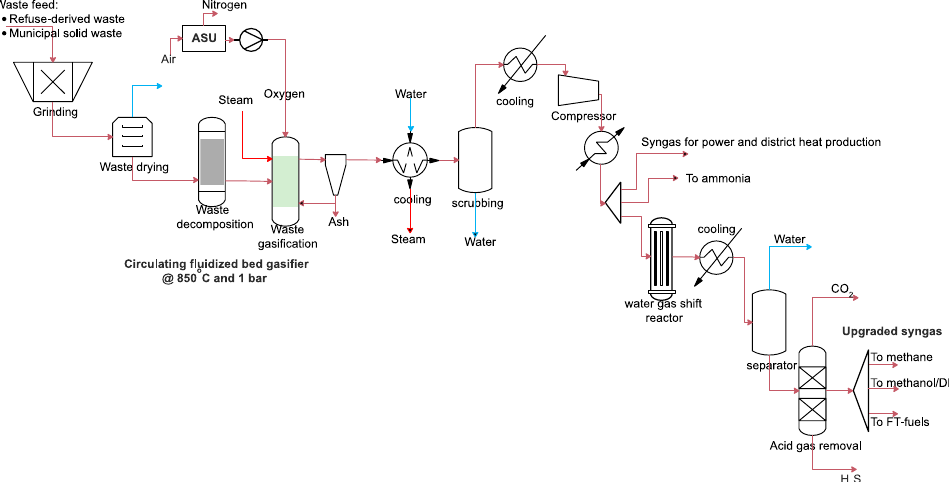
Figure 3. Process flow diagram of gasification of MSW and RDF in the directly heated CFBG.